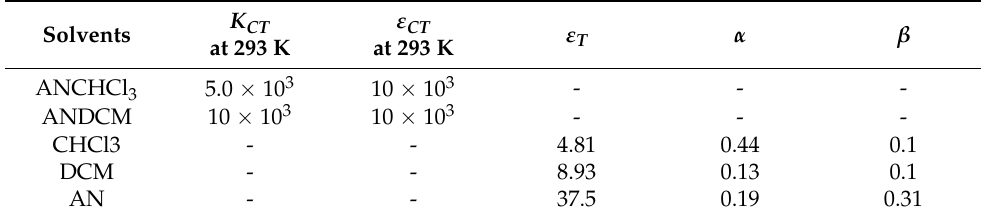
Table 3. Solvent parameters of the formation constant and the molar extinction coefficient of the AMFP–DDQ CT complex in different solvents